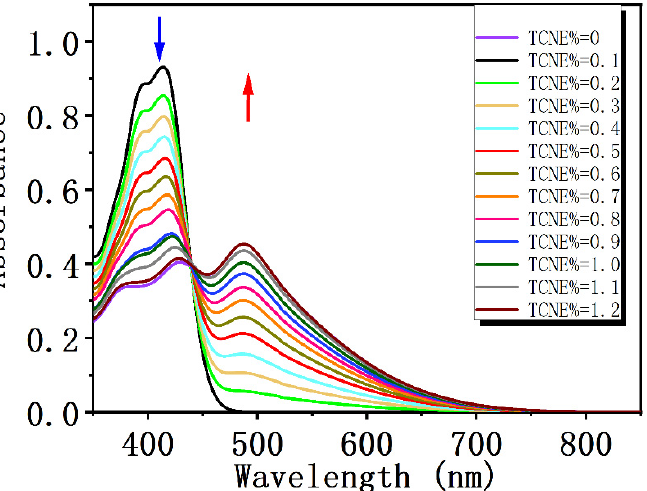
Figure 3. Normalized UV-vis spectral changes of PY-C16 during the TCNE titration in dichloro- methane.